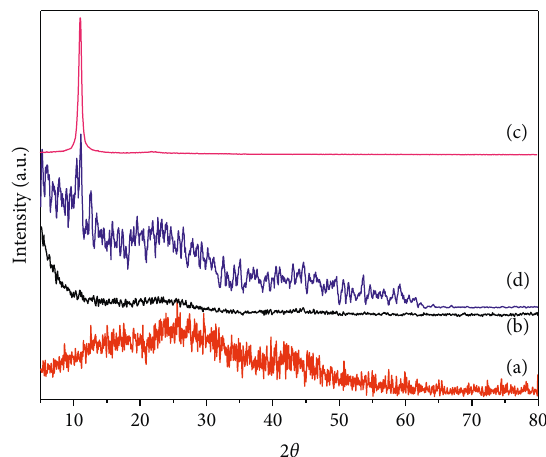
Figure 1: XRD patterns of sulfonated biochar (a), activated carbon (b), graphene oxide (c), and GO/AC